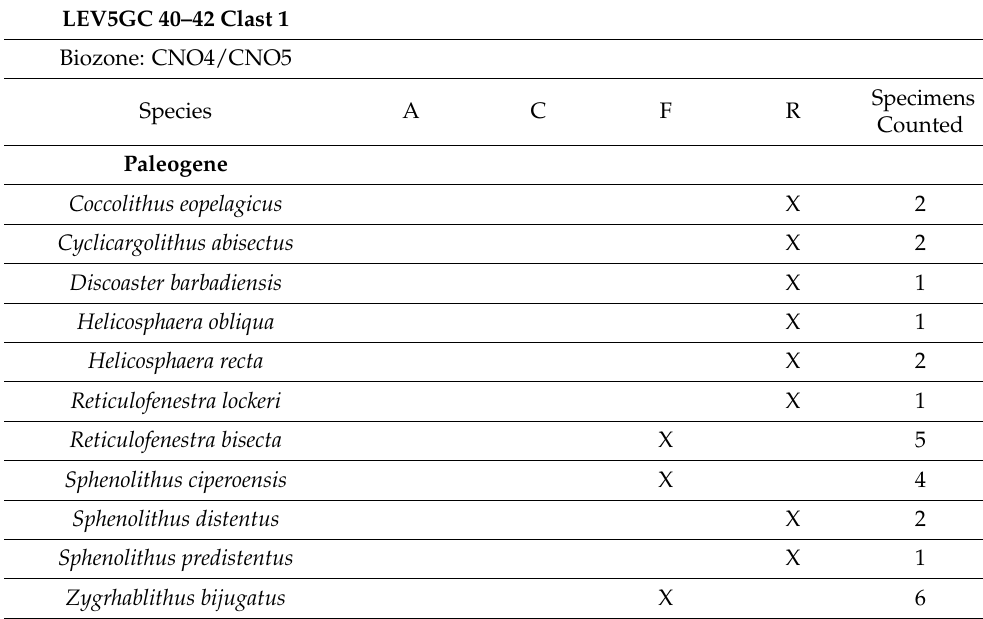
Table A20. Moscow